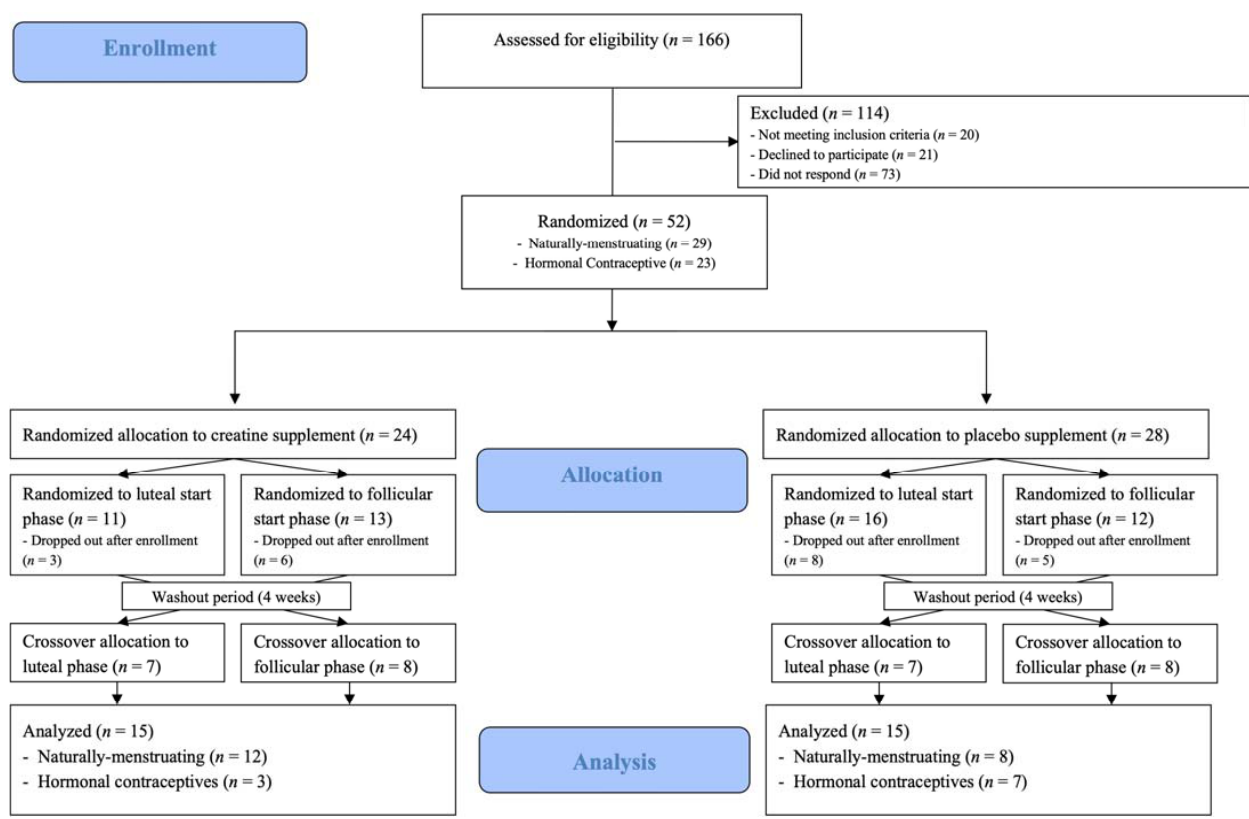
Figure 1. CONSORT (Consolidated Standards of Reporting Trials) diagram. Table 1. Demographics of the sample.